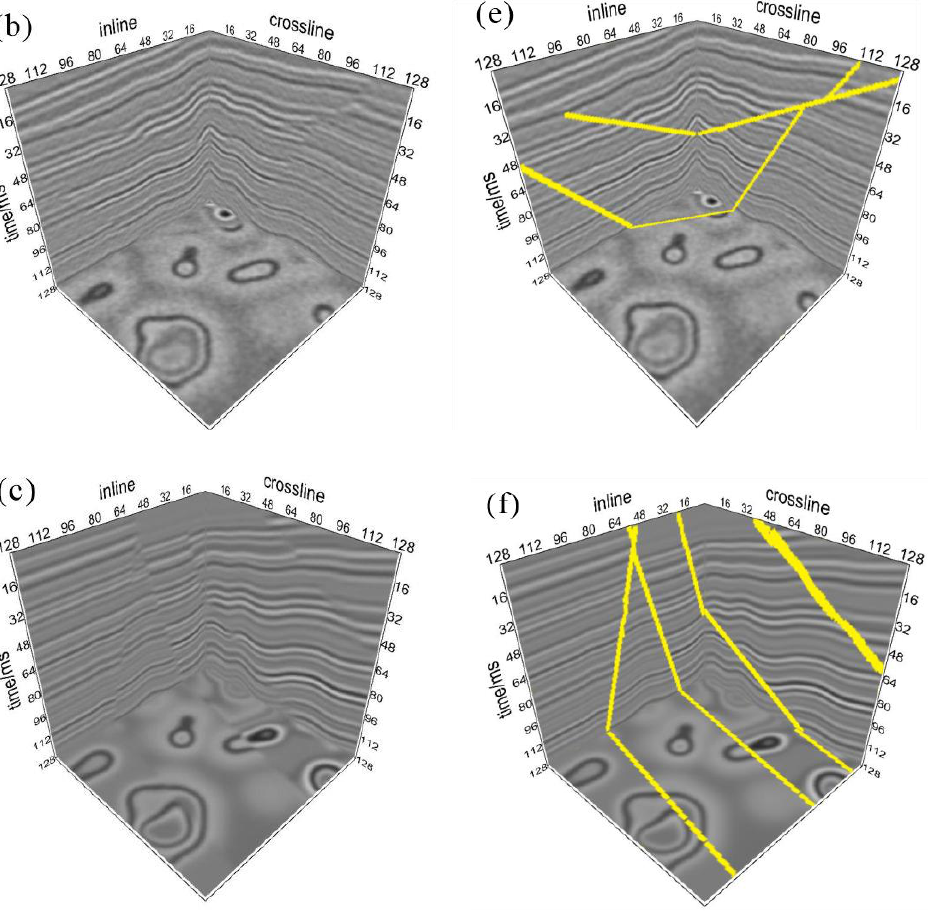
Figure 4. Three-dimensional low-grade sample set. ( a ) Disconnection of the seismic event; ( b ) dislocation of the seismic event; ( c ) twists of the seismic event; ( d – f ) are the fault labels of ( a – c ).